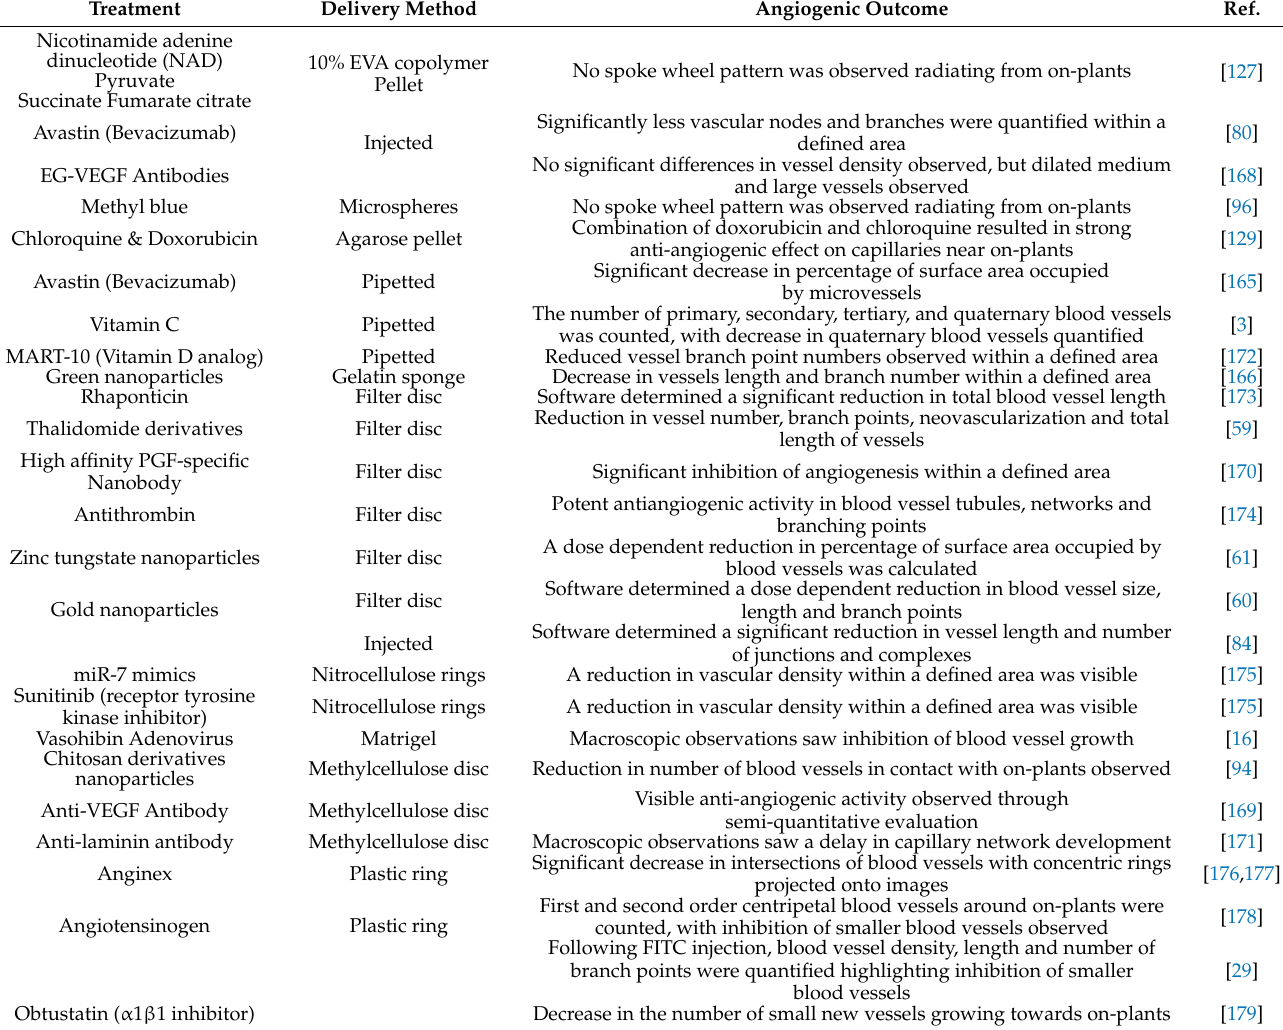
Table 3. Examples of protein, viral, micro-RNA and pharmacological treatments applied to the CAM which elicited an anti-angiogenic